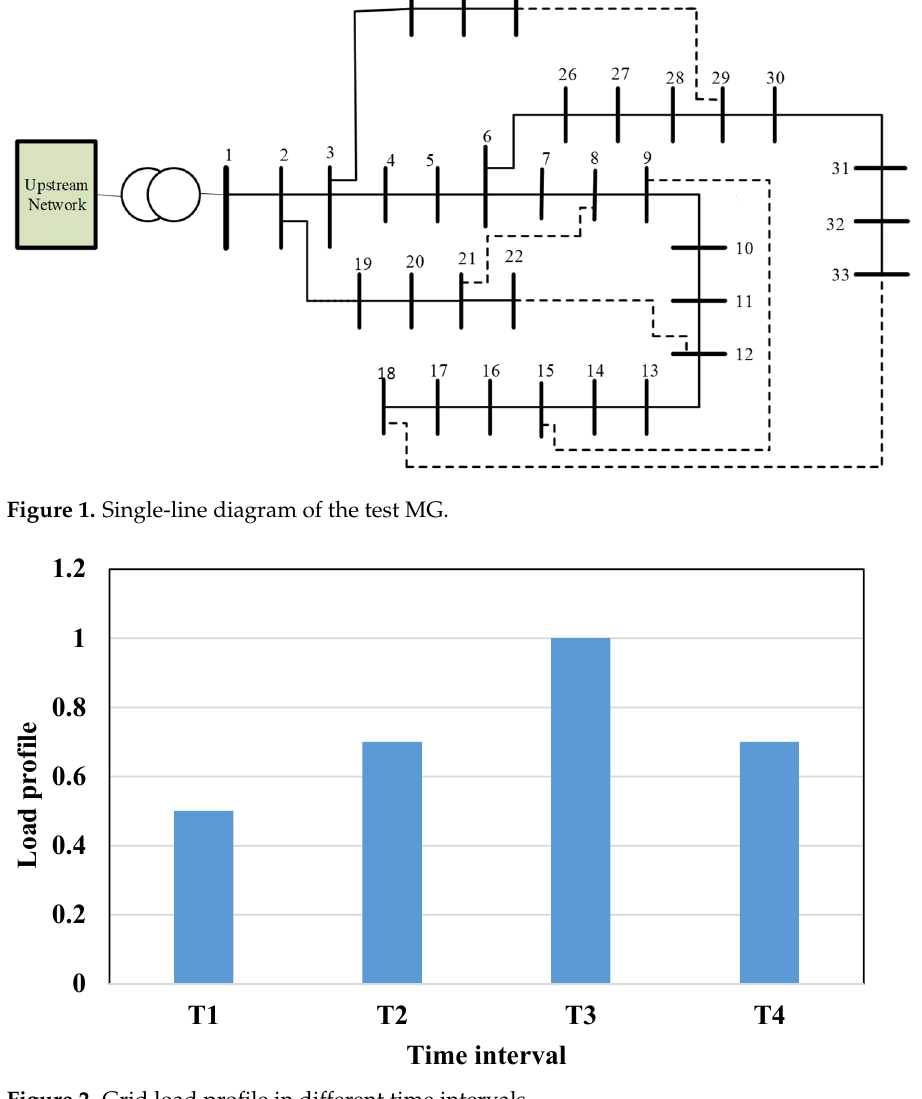
Figure 2. Grid load profile in different time intervals. Table 2. The data of ESS units.